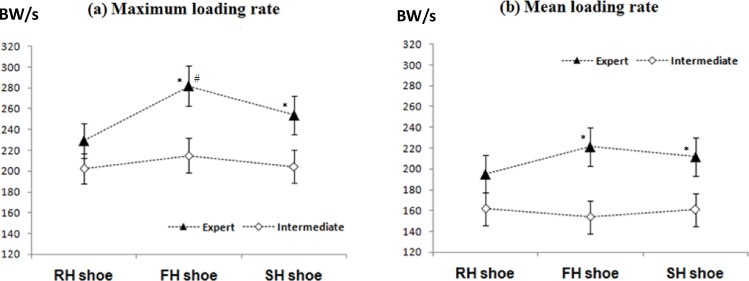
Shoe x Group interaction for (a) maximum vertical loading rate and (b) mean vertical loading rate during left lunge direction. *represents significant difference between RHS; #represents significant difference between SHS.